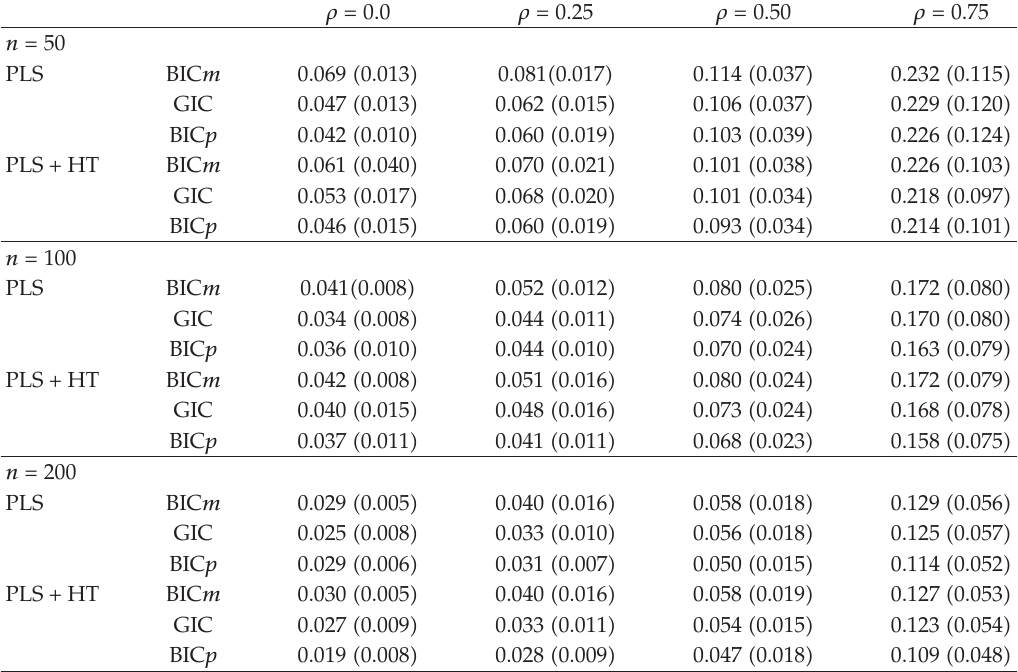
Table 1: Means (cid:3) standard deviations (cid:6) of RASE α . ρ (cid:7) 0 . 0